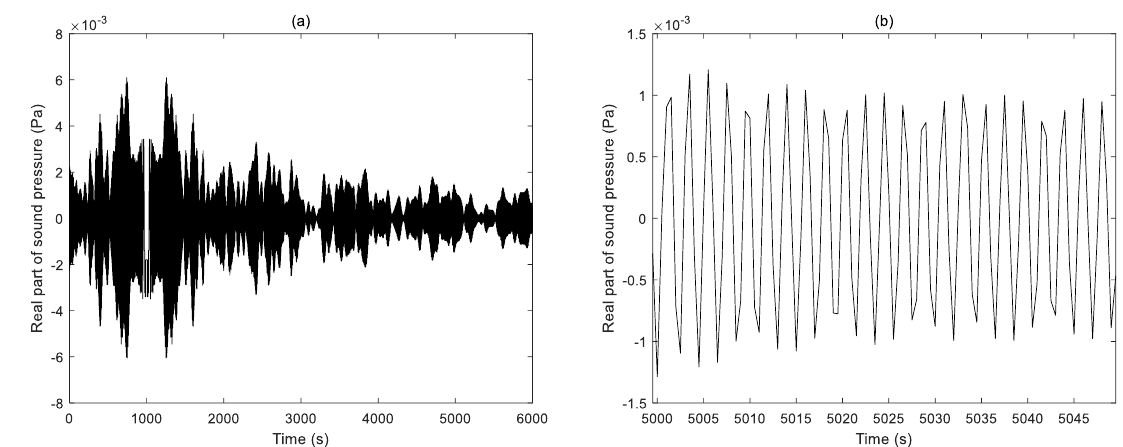
Figure 2. Variation of the real part of sound pressure versus time: ( a ) the overall view of the first 6000 seconds and ( b ) the enlarged detail between the 5000th and 5050th seconds.